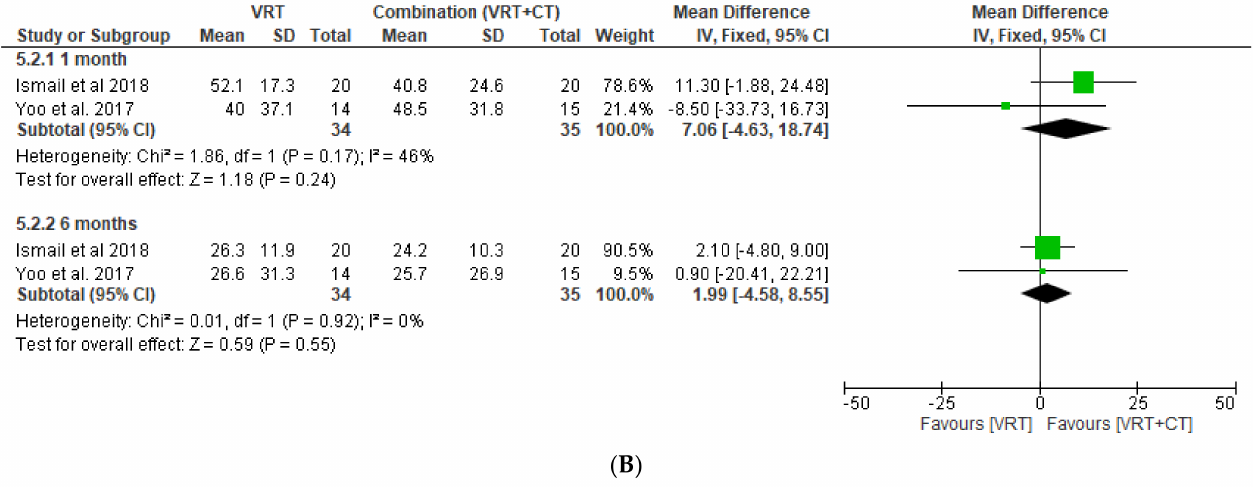
Figure 5. Forest plots of comparison of DHI score at 1 month and 6 months ( A ); and canal paresis at 1 month and 6 months ( B ) in VRT and combination groups